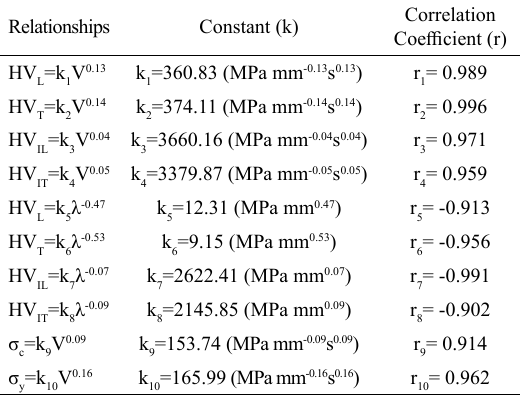
Table 3. The relationships between the solidification rate and the mechanical properties Relationships